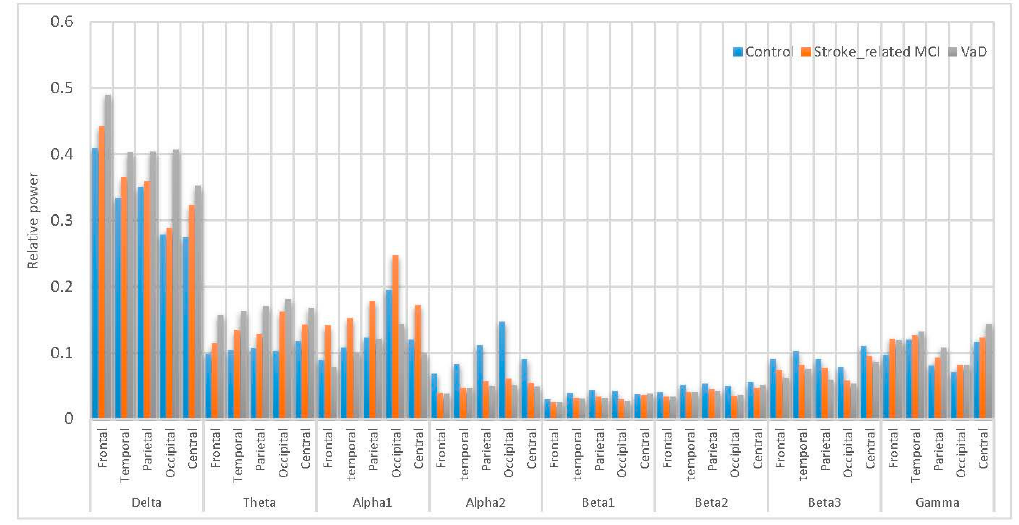
Figure 13. Comparative plot of the RP for the scalp regions for VaD, stroke-related MCI patients and control subjects using AICA–WT.